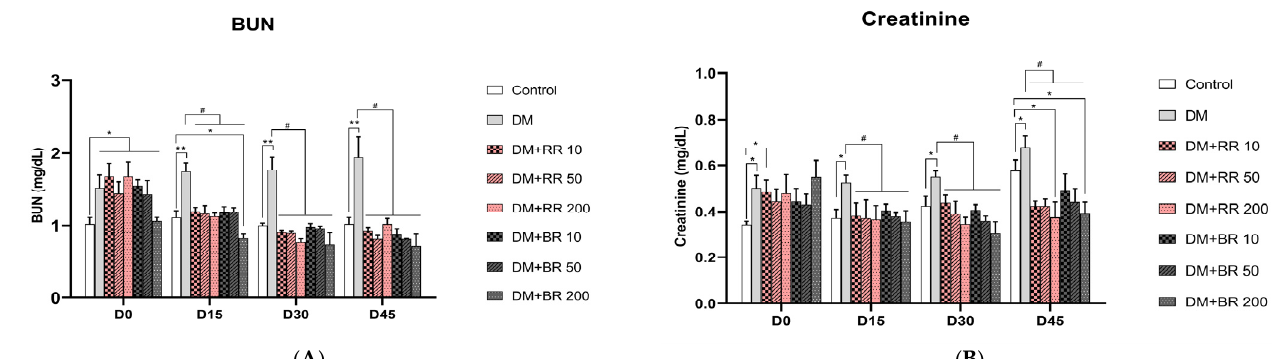
Figure 6. Effects of various doses of RR and BR on BUN ( A ) and creatinine ( B ) levels of STZ-induced diabetic rats. * p < 0.05 and ** p < 0.01, diabetic control group vs. control group; # p < 0.05, treated group vs . diabetic control . Values represent mean ± S . E . M . (n = 8) .